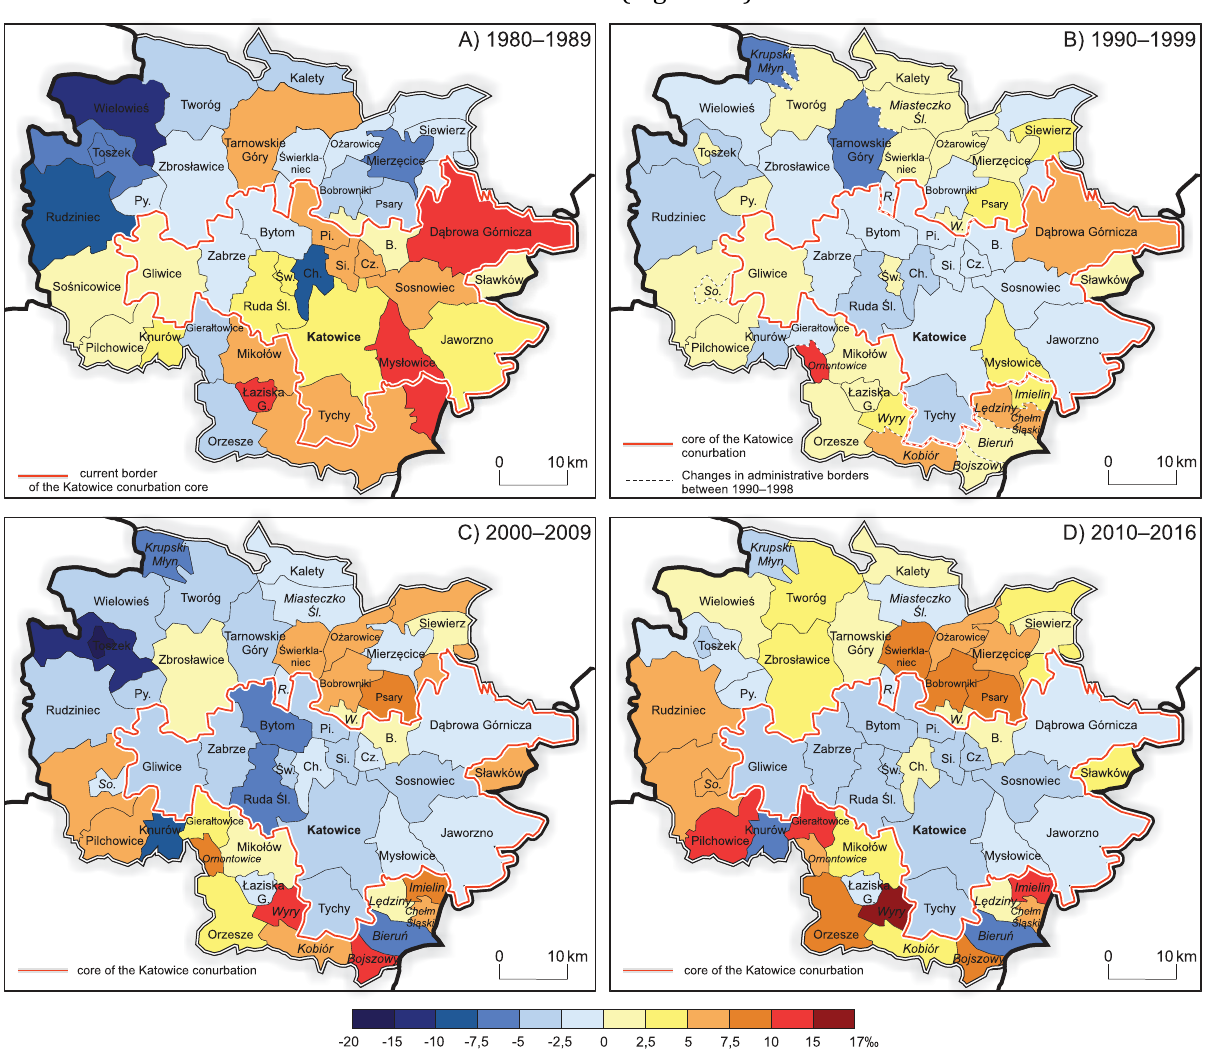
Fig. 6. Net migration coefficients (aggregative) for the communes of the Katowice conurbation for the periods A)